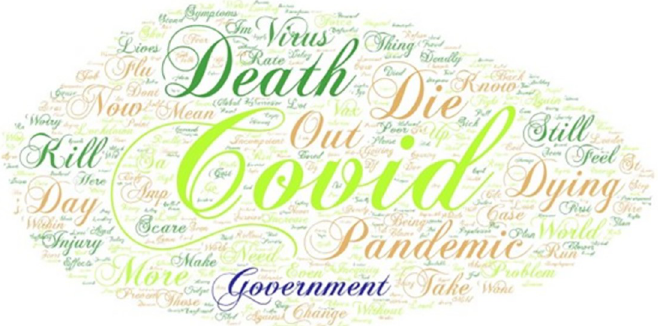
Fig 3. Word cloud based on negative sentiment for vaccine-related tweets, South Africa. Source: Authors own compilation using word cloud software.